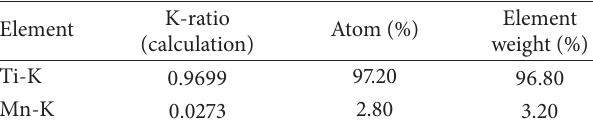
Table 4: Statistical results of metal on rutile TiO manganese by